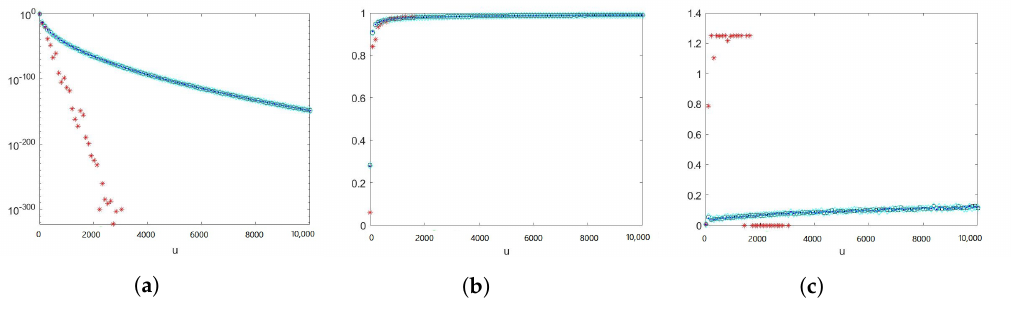
Figure 3. The random variable N is geometrically distributed with success probability p = 0.2, W i i.i.d ∼ Exp ( 1 ) , X i i.i.d ∼ Erlang ( 1,3 ) , where i = 1, . . . , N . Black squares: ConAK1+IS+CV (conditioning and IS on exponential). Red stars: ConAK2+CV. Blue dots: ConAK2+IS+CV (conditioning and IS on Erlang using an exponential PDF). Cyan diamonds: ConAK2+IS+CV (conditioning and IS on Erlang using an Erlang PDF). ( a ) Estimates of (cid:96) ( u ) as a function of u on a logarithmic scale. ( b ) Empirical logarithmic rates as a function of u . ( c ) Empirical relative errors as a function of u . Example 4 (Heavy-tailed Scaling: Weibull) . Let the scaling random variable W i be Weibull- distributed, with